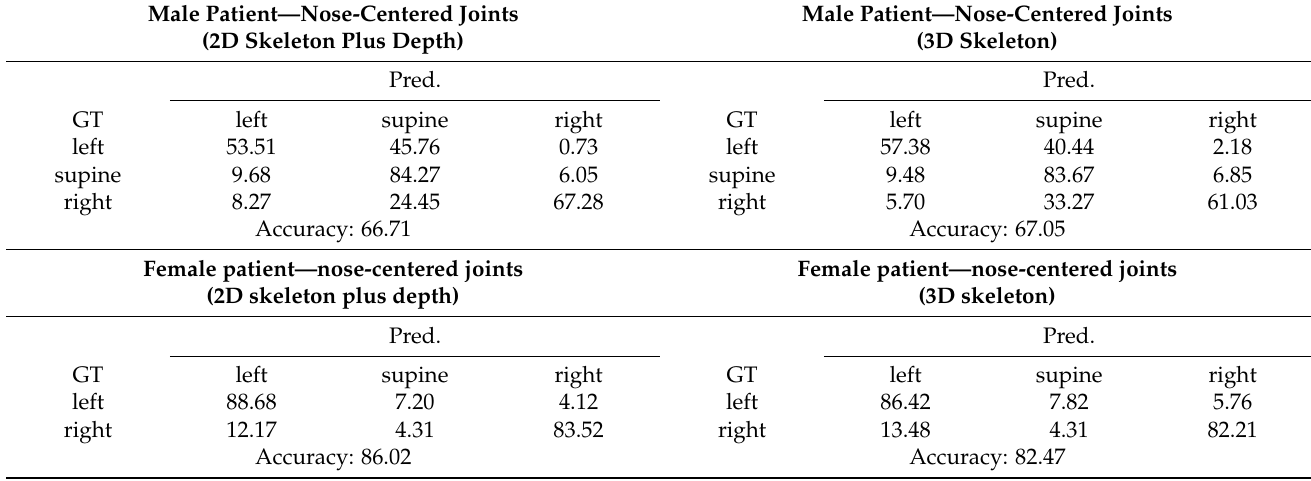
Table 7. Accuracy and confusion matrix (all numbers in terms of %) for Setting 3.